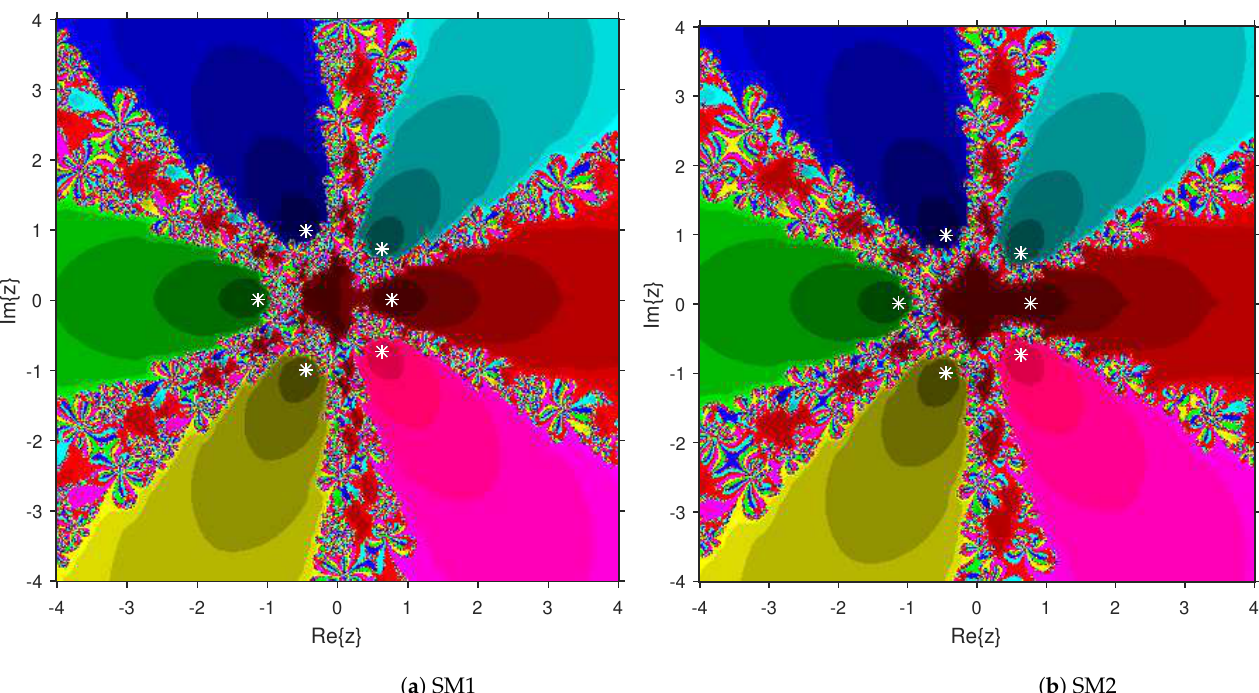
Figure 10. Attraction basins comparison between SM1 and SM2 corresponding to M 10 ( z )